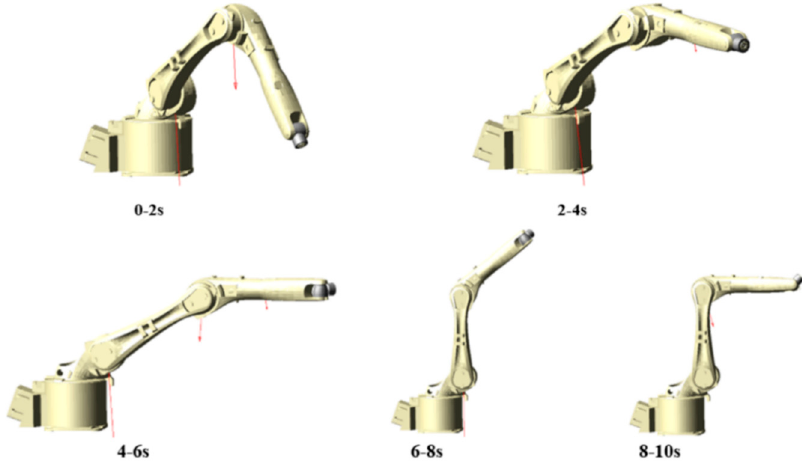
Figure 19. Different working spaces traveled by end-effectors at different times.